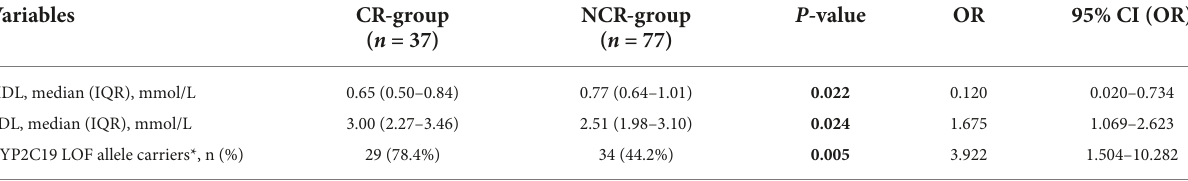
TABLE 4 Multivariable logistic regression analysis for CR in children with KD.